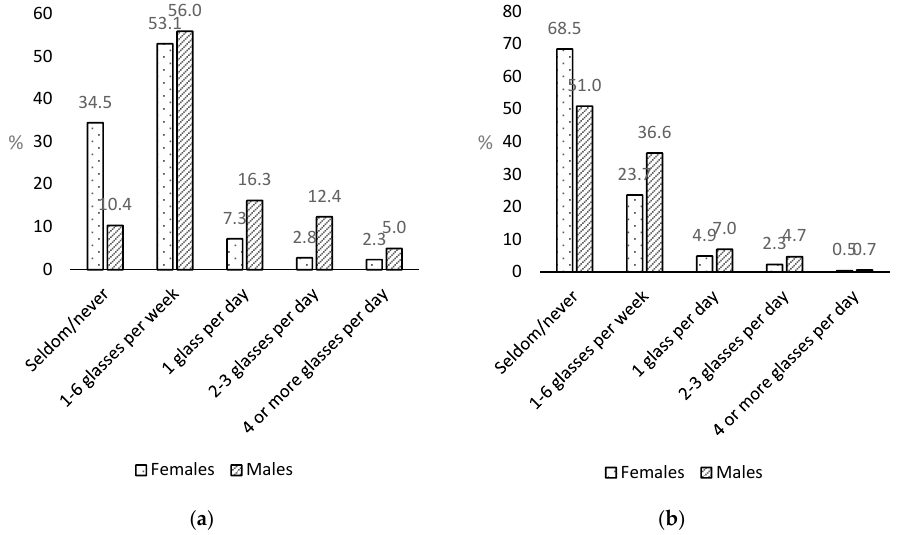
Figure 1. Intake of ( a ) carbonated sugar-sweetened beverages (SSB); and ( b ) non-carbonated SSB, by sex.